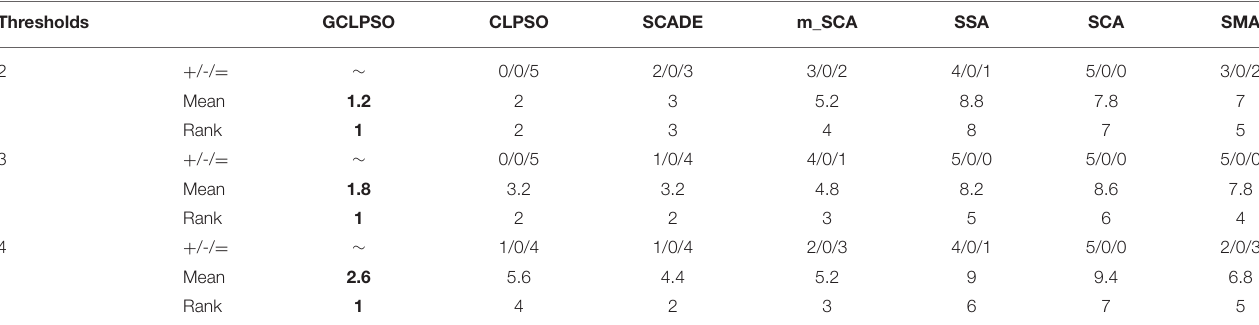
TABLE 4 | Results of the structural similarity (SSIM) comparison by the Wilcoxon signed-rank test at each threshold level of maize leaf spot disease.